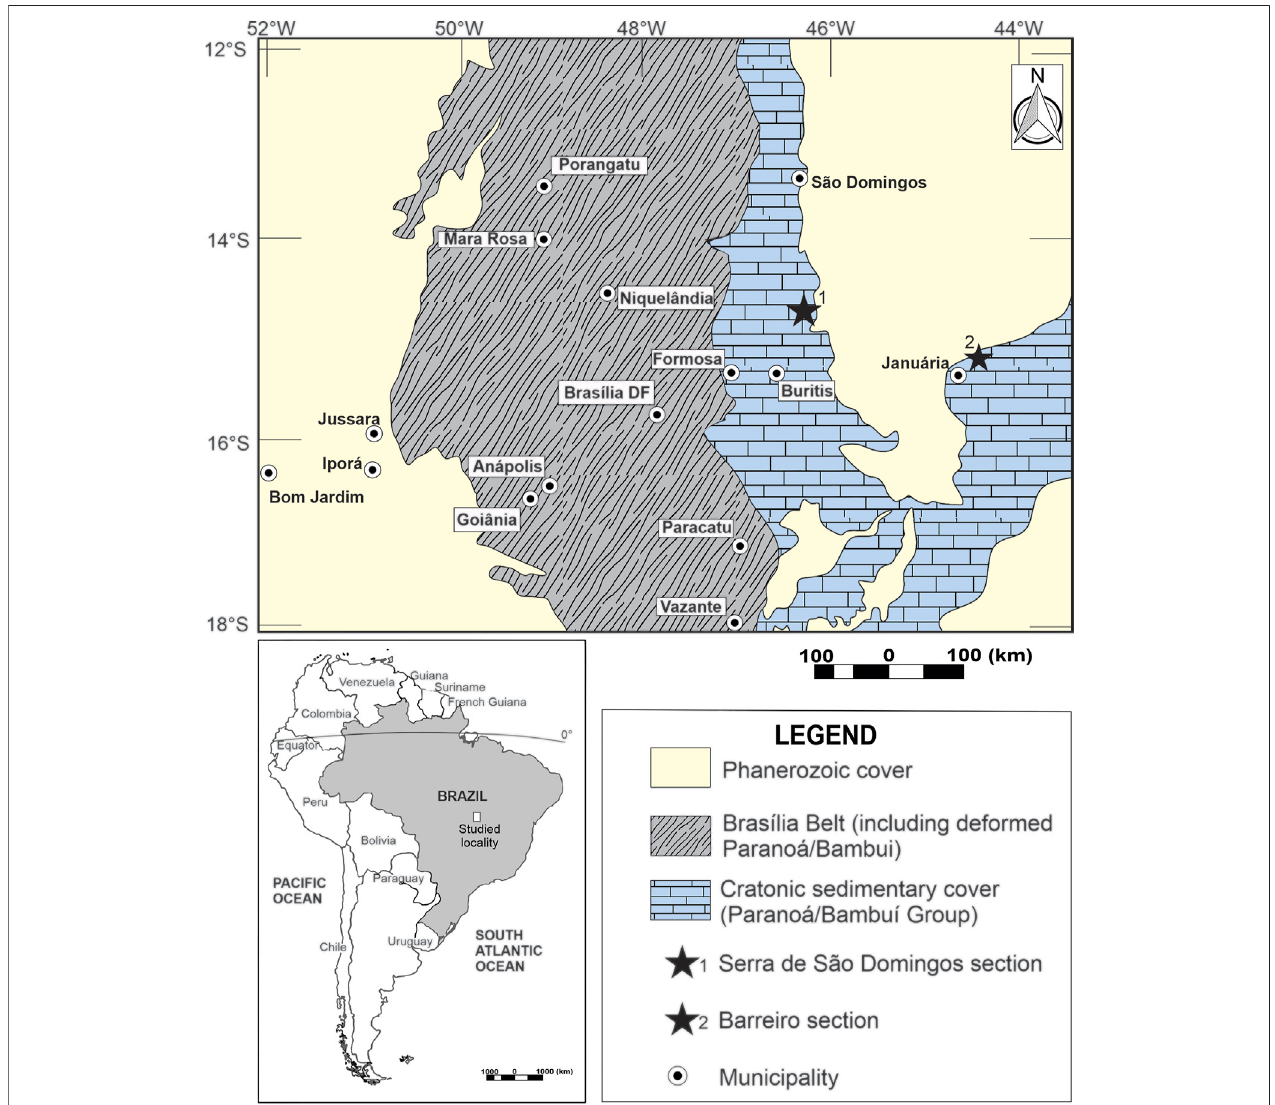
FIGURE 1 | Geological map of studied areas in Brazil. (1) Serra de São Domingos section, Buritis Municipality, Minas Gerais State; (2) Barreiro section, Januária Municipality, Minas Gerais State.